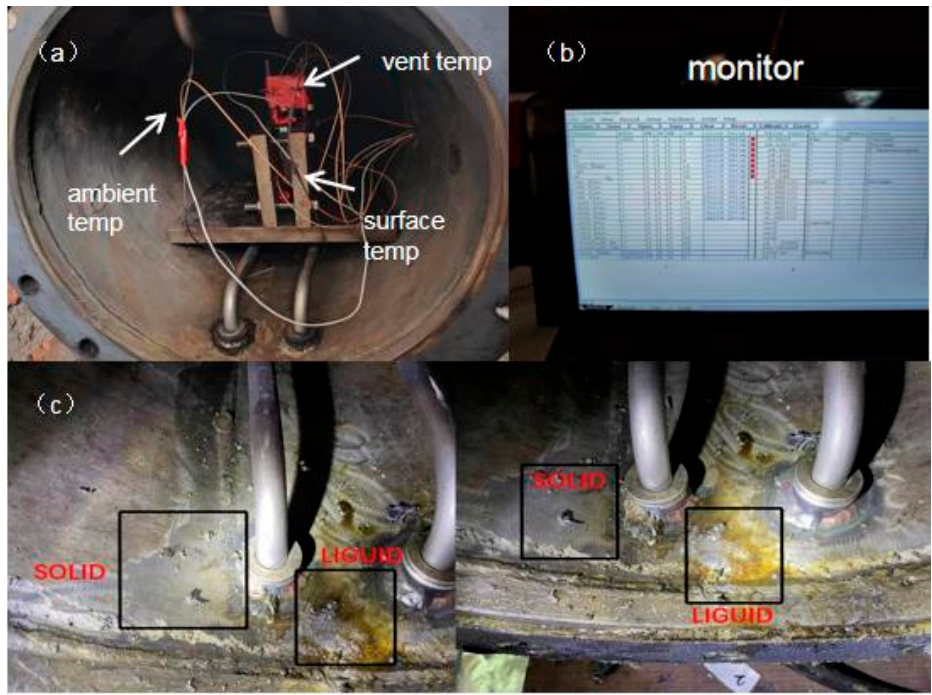
Figure 3. Photos of the experiment show how the temperature sensor was arranged and the residue that was left within the experimental equipment after the experiment. ( a ) Schematic diagram of temperature sensor. ( b ) Schematic diagram of data parameter monitoring. ( c ) Schematic diagram of the interior of the chamber after the experiment.